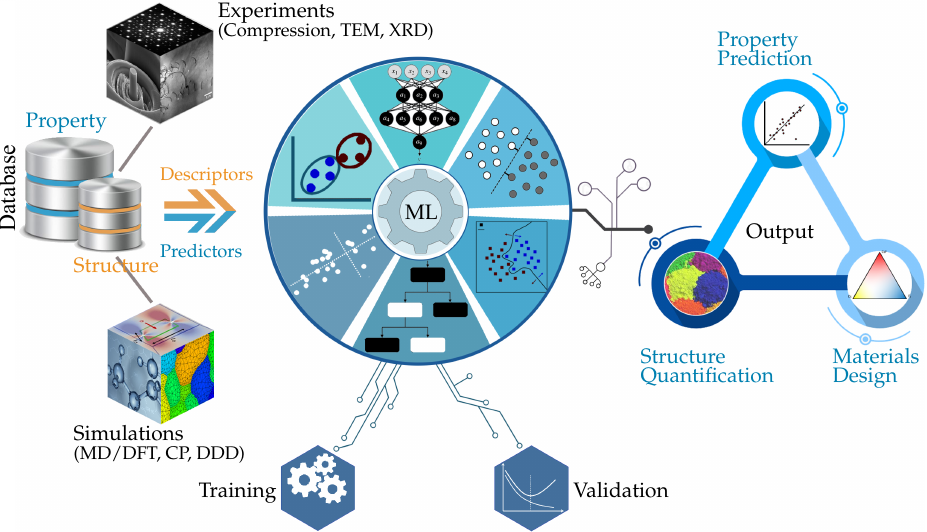
Figure 1. A typical materials informatics workflow for applications related to mechanical defor- mation. Databases (left) generated through microscopy and (nano)mechanics experiments are combined with multiscale modeling simulations to provide relevant descriptors and predictors. The latter are used to train and validate ML algorithms (center) leading to the property prediction, structural characterization, and materials design/discovery (right).